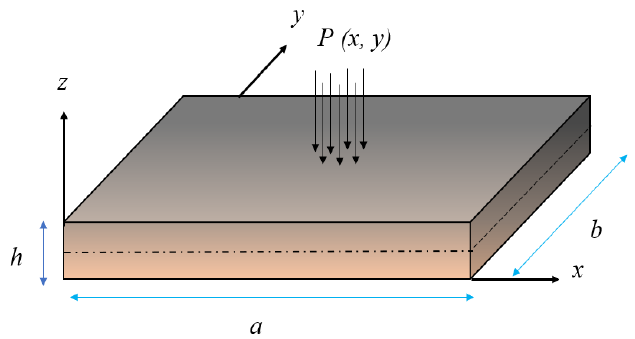
Fig. 1. FG 3D laminate exposed to thermal